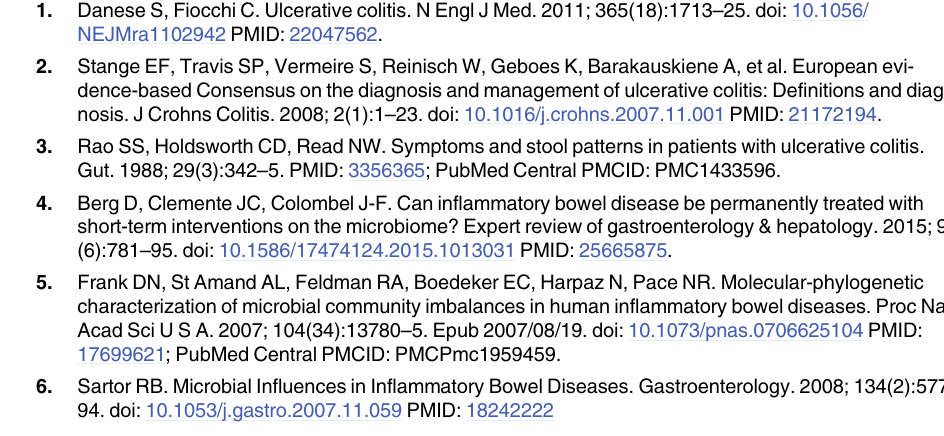
S2 Table. Assessment of Risk of bias in included RCT studies and cohort